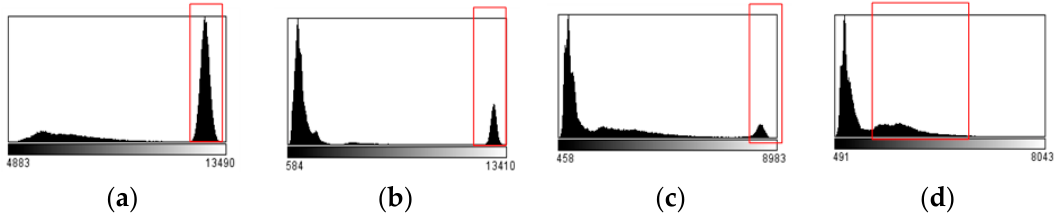
Figure 5. Histogram of part of the image sequence. ( a ) Sequence image 1; ( b ) sequence image 2; ( c ) sequence image 3; ( d ) sequence image 4.